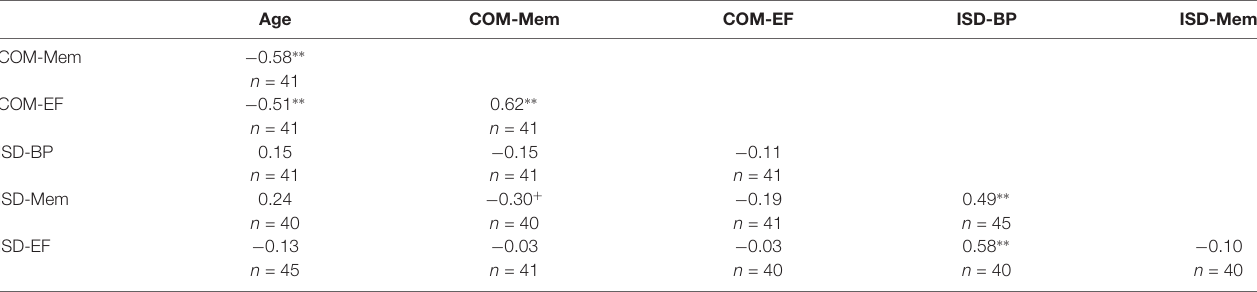
TABLE 2 | Bivariate correlations amongst cognitive scores and chronological age. Age COM-Mem COM-EF ISD-BP ISD-Mem